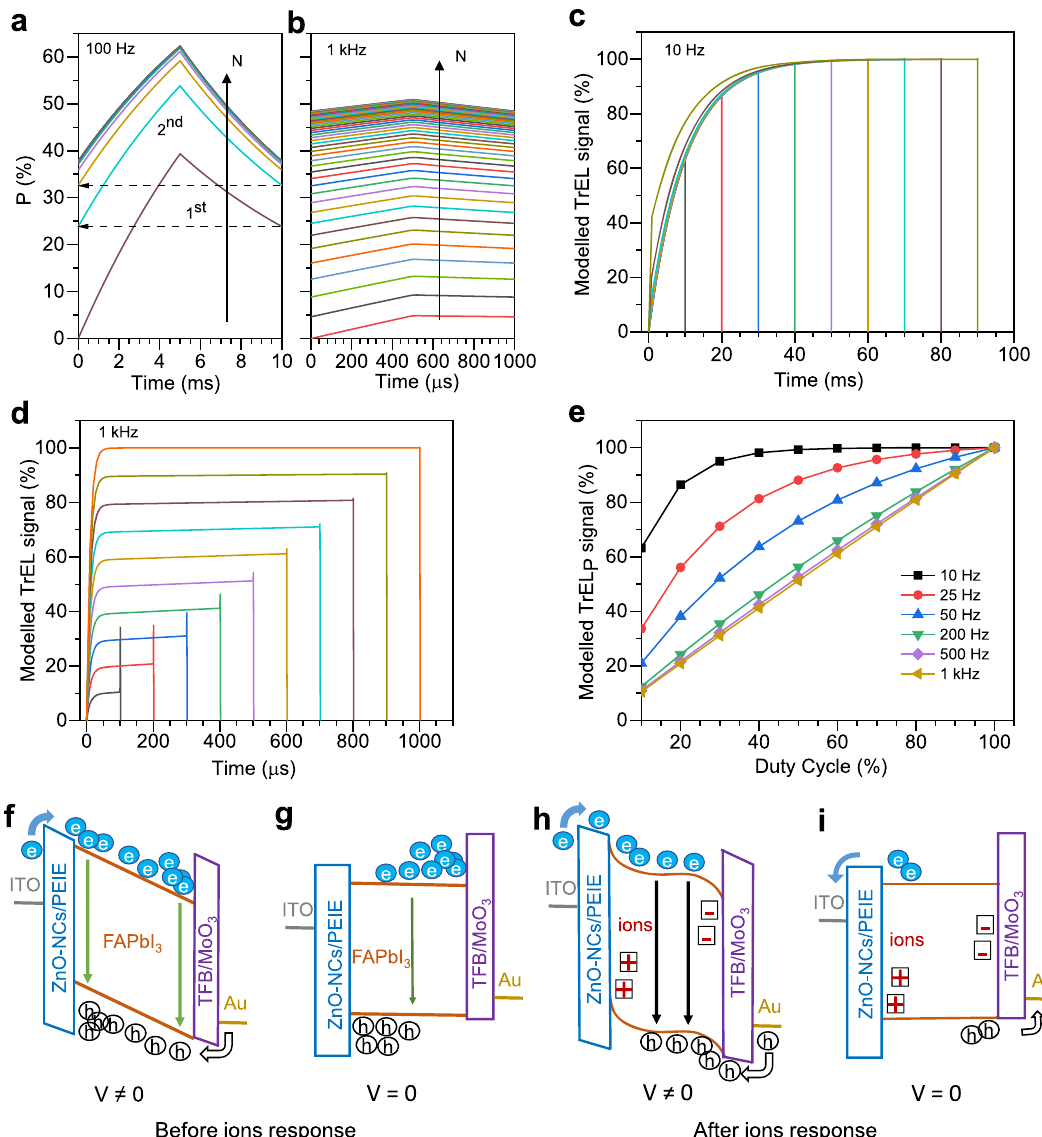
Fig. 4 Modelled transient electroluminescence (TrEL) dynamics as a functions of pulse width and frequency. Probability function P as de fi ned in the Eqs. (1) and (2) for a 100 Hz and b 1 kHz. The arrow (solid vertical black) indicates the increasing cycle number N . For the 1st and 2nd cycle, the dashed arrows indicate that the start value of a new cycle is the end value of the preceding cycle. c and d Modelled converged TrEL signal as a function of pulse width for 10 Hz and 1 kHz, respectively. e Modelled TrEL P signal versus duty cycle as a function of frequency variation . f – i Sketch of the band diagram after applying a positive forward voltage pulse f , g before and h , i after ions responded. The vertical arrows indicate regions of high